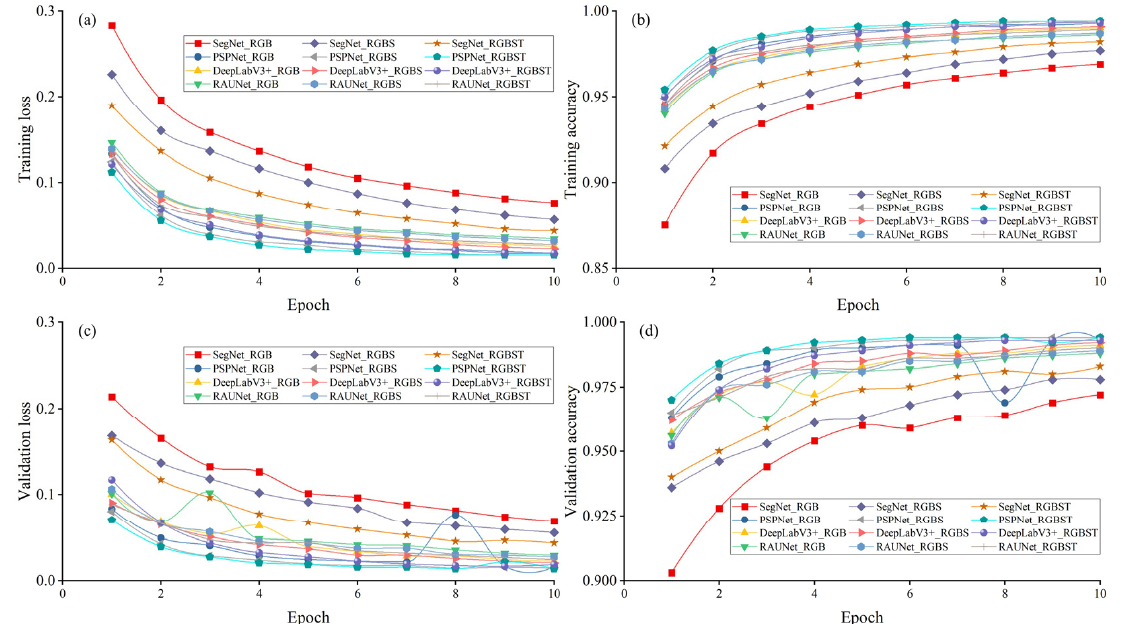
Figure A3. Training and validation curves for one-class classification of KWP. ( a ) Training loss; ( b ) training accuracy; ( c ) validation loss; ( d ) validation accuracy.